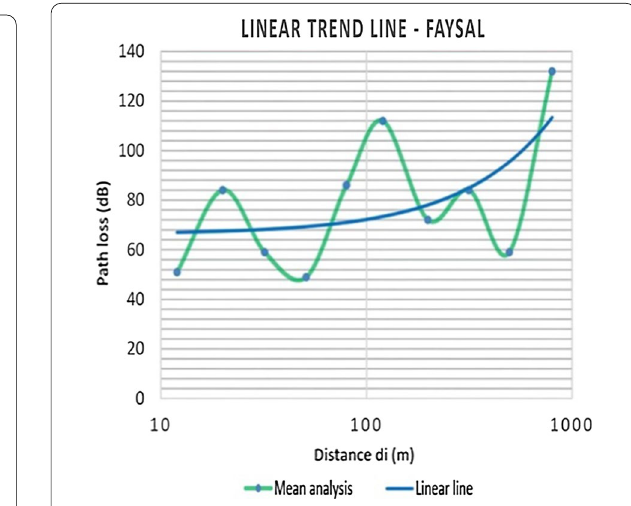
Fig. 4 Regression analysis—linear trend line—Dokki Fig. 5 Regression analysis—linear trend